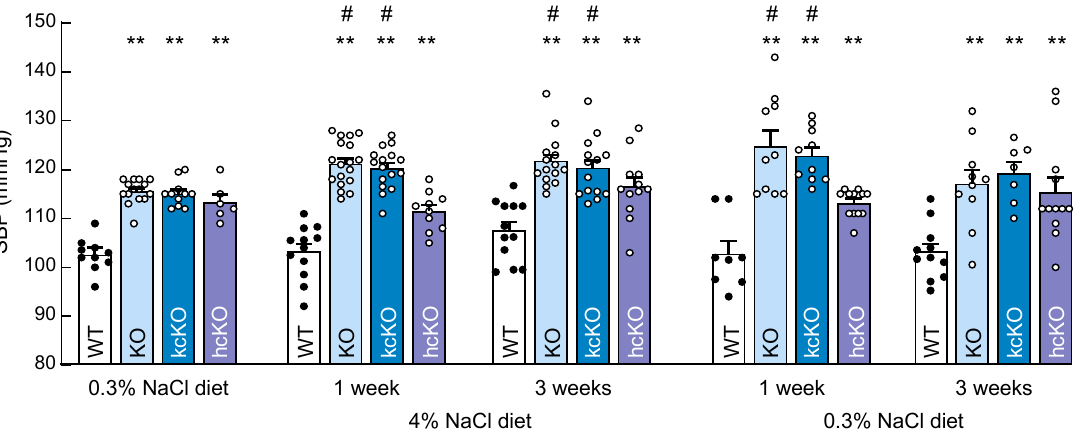
Figure 5. Salt-exacerbated hypertension in corin KO and kcKO mice. Systolic blood pressure (SBP) was measured in male WT (black dots), corin KO, kcKO, and hcKO (white dots) mice fed a 0.3% NaCl diet, then a 4% NaCl diet for one and three weeks, then back to a 0.3% NaCl diet for one and three weeks. ** p < 0.01 vs. WT of the same group. # p < 0.05 vs. the same genotype on initial 0.3% NaCl diet. n = 6–18 per group. Data shown are mean ± SEM. P -values were analyzed by one-way ANOVA.